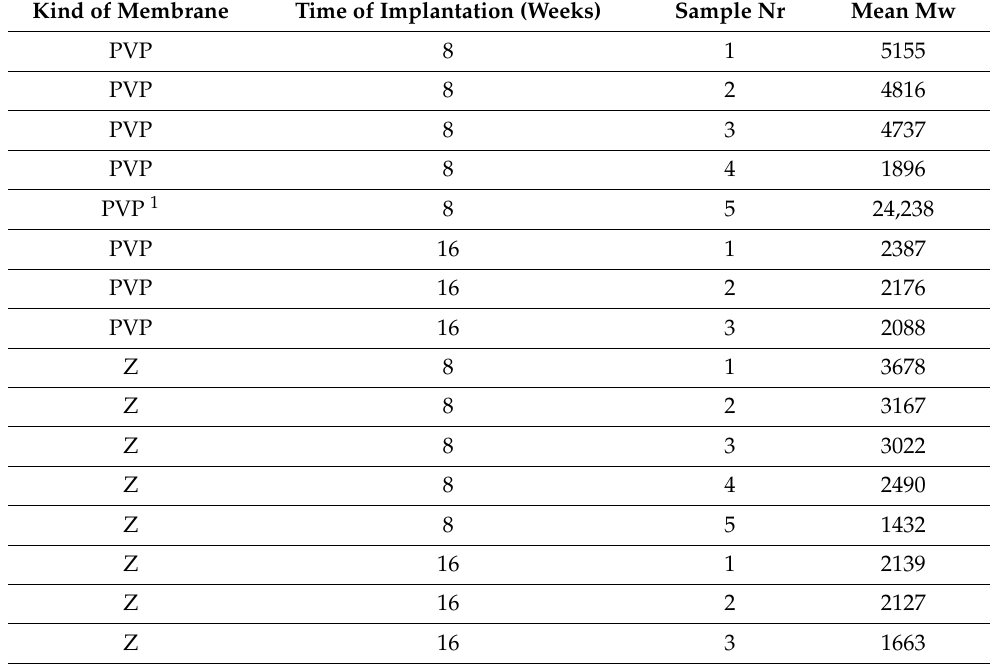
Table 1. Results of the GPC examination. Kind of Membrane Time of Implantation